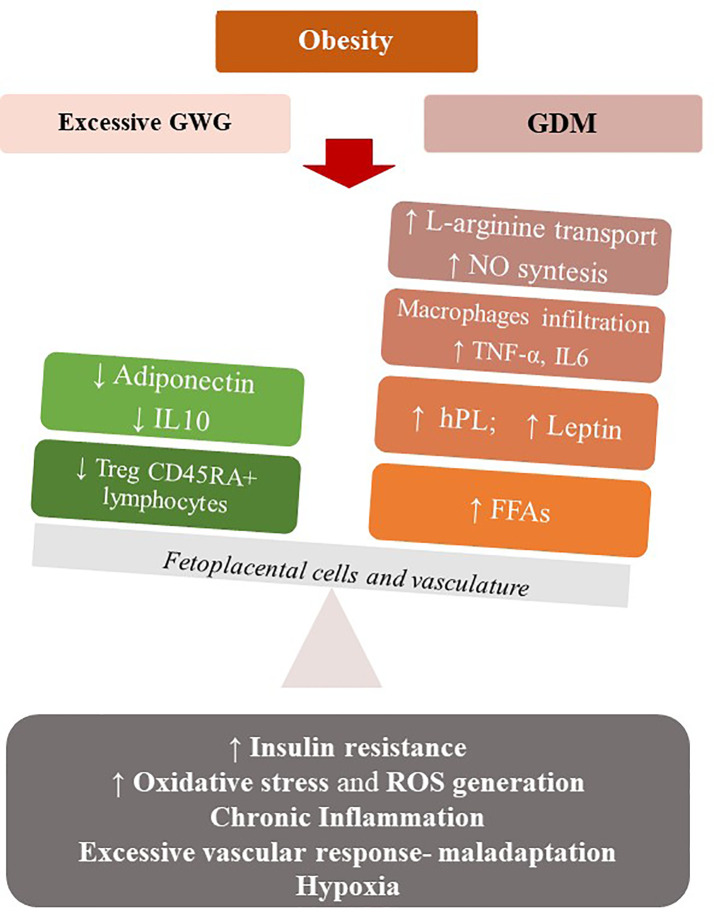
Maternal obesity, excessive GWG and GDM may be associated with a state of low-grade chronic inflammation that configure a metabolic condition (Gestational Diabesity) sharing a common pathogenetic substrate: the loss of balance between the physiological pro- and anti-inflammatory responses of pregnancy and an enhanced pro-inflammatory response. Increased levels of leptin and TNF- α, a state of hypoxia, abnormal oxidative stress, vascular maladaptation and enhanced ROS generation result in insulin resistance in the feto-placental vasculature, with reduced levels of adiponectin and IL-10 and increasing NO bioavailability. At the systemic level, there is a de-regulation of the immune system, with reduction of Treg cells and their tolerogentic activity of immune-suppression. hPL, Human Placental Lactogen; TNFα, Tumor Necrosis Factor α; FFA, Free Fatty Acids; IL-6, Interleukin 6; IL-10-Interleukin-10; ROS, Reactive oxygen species.